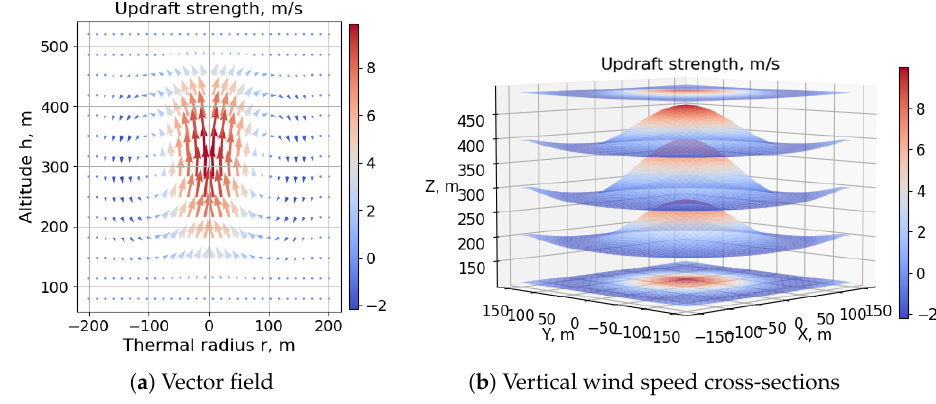
Figure 4. Toroidal thermal bubble